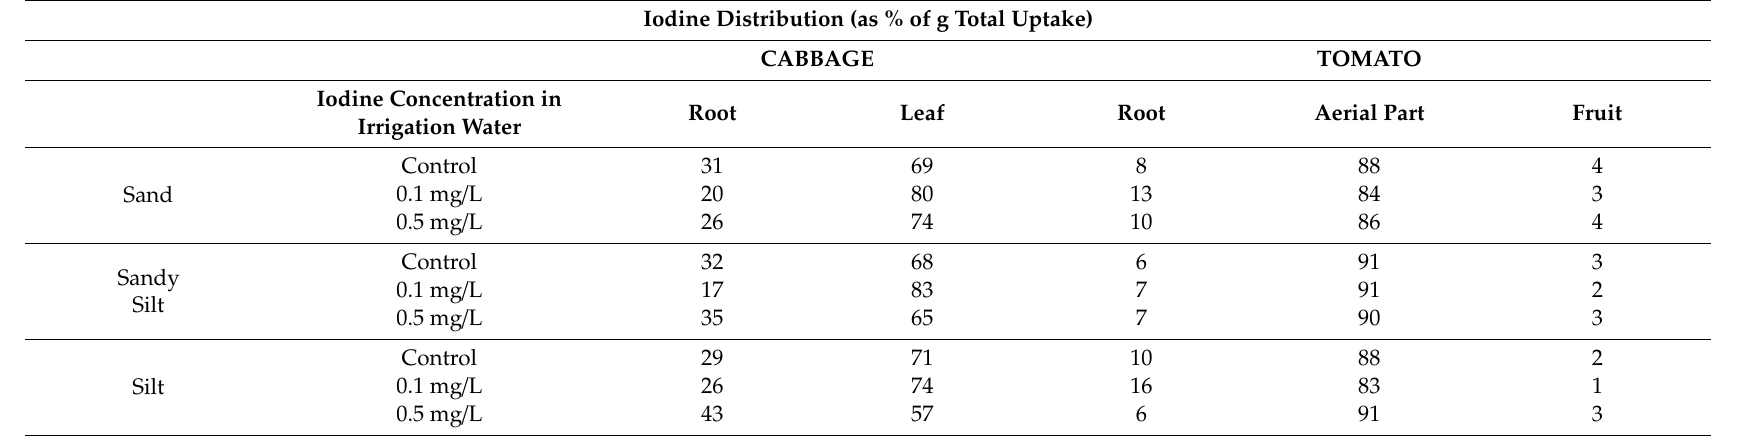
Table 4. Iodine distribution in cabbage and tomato plants cultivated in di ff erent